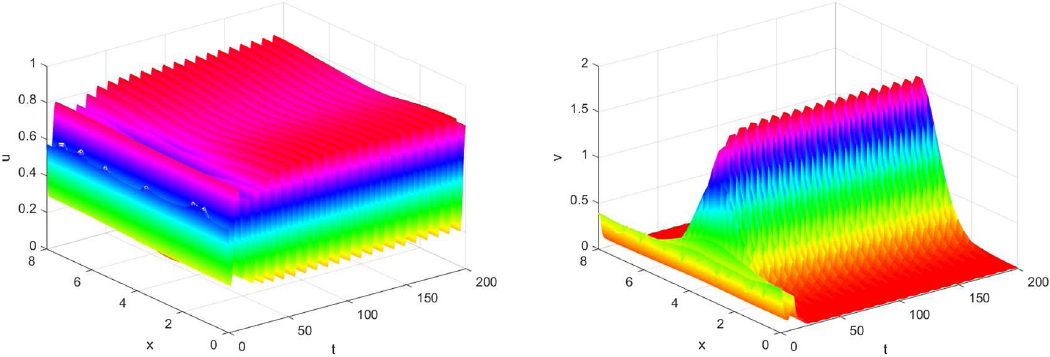
Figure 8: Phase portraits of ( 1.5 ) with parameters = = = = a σ d d 4.1, 1, 10, 0.2 1 2 . Bifurcated homogeneous periodic solution is